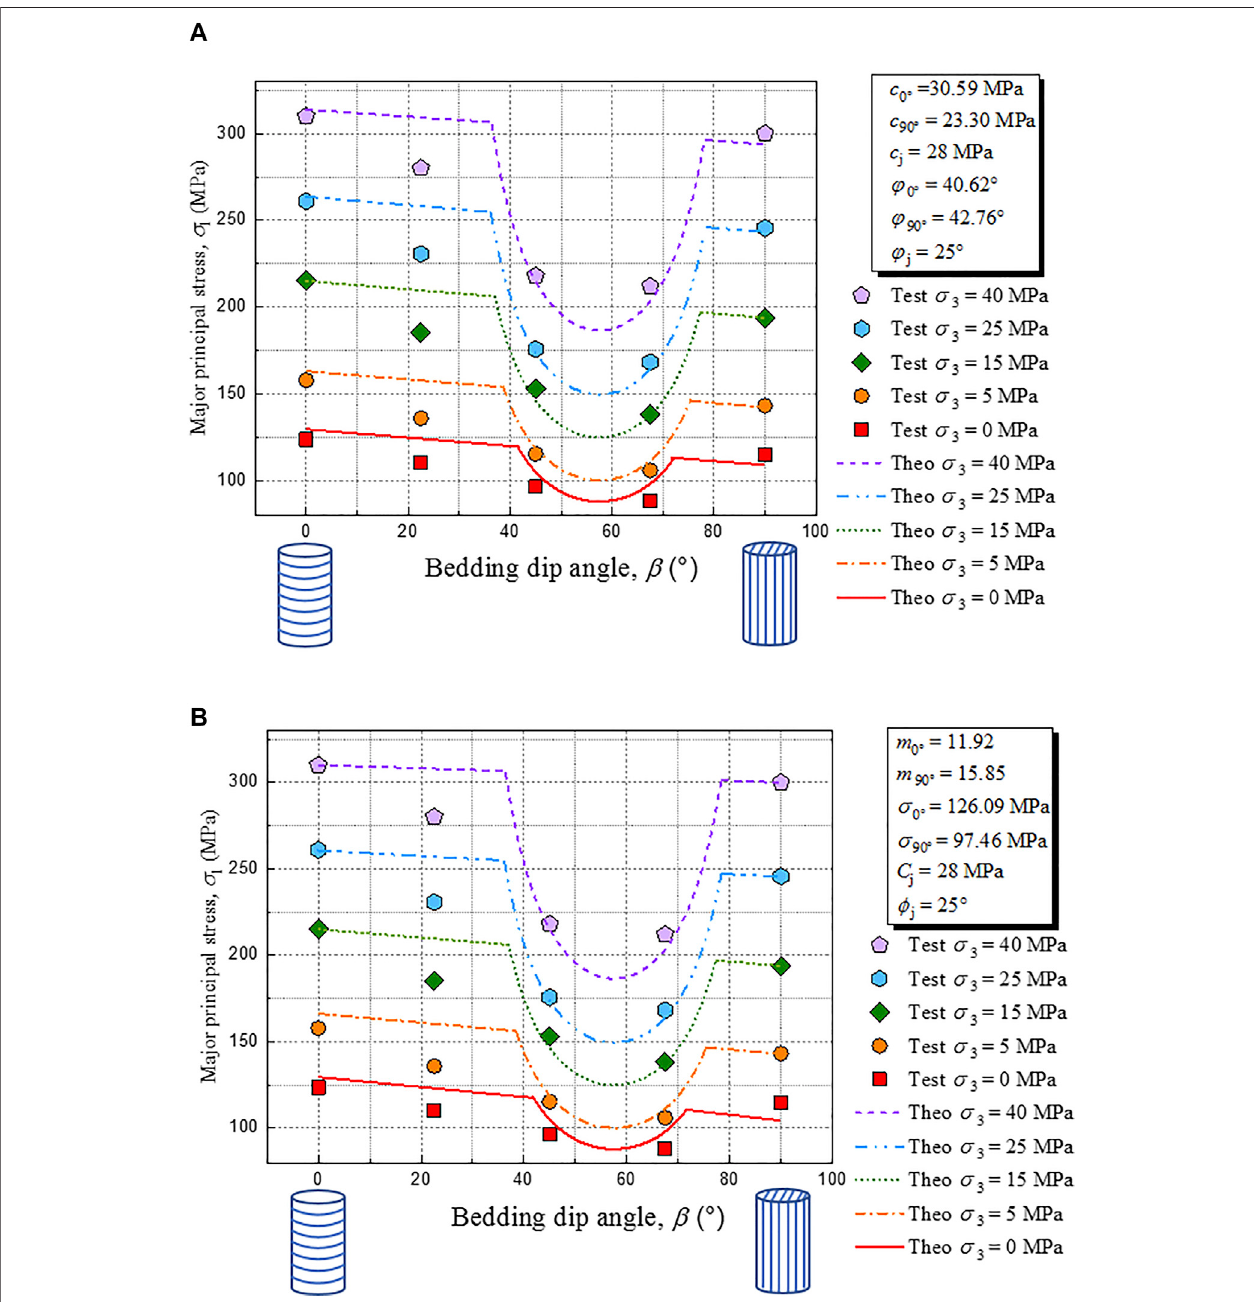
FIGURE 11 | (A) Predicted strength curves of the JPW-MC model and experimental values and (B) predicted strength curves of the JPW-HB model and experimental values.